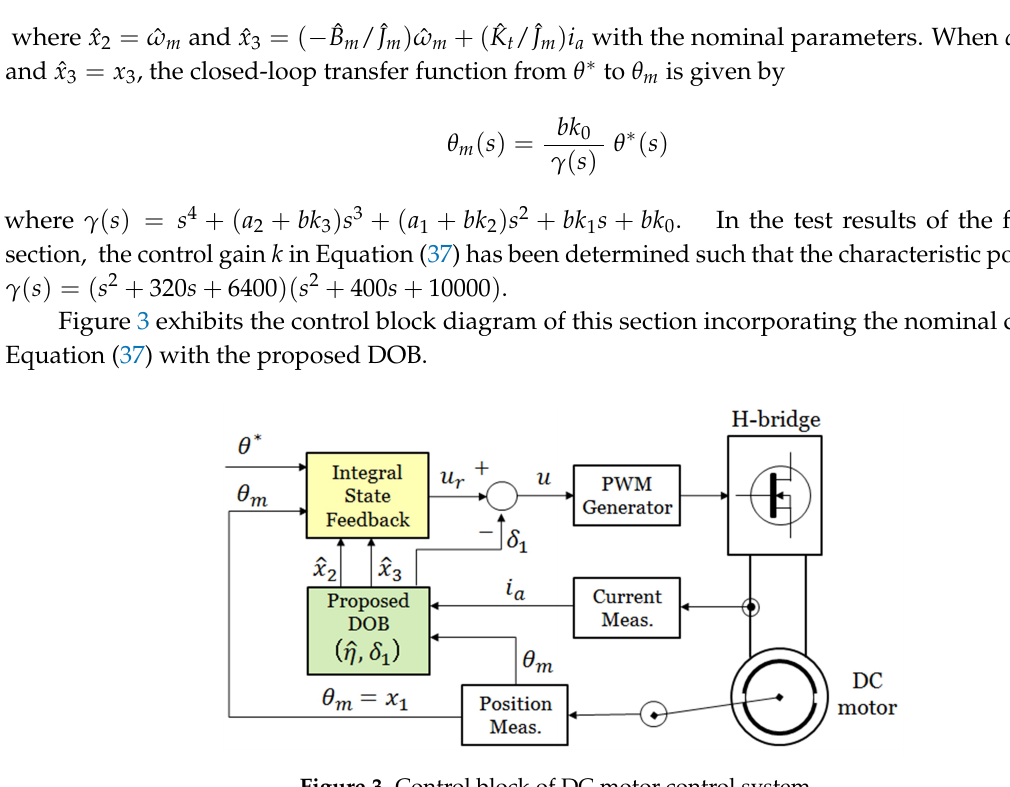
Figure 3. Control block of DC motor control